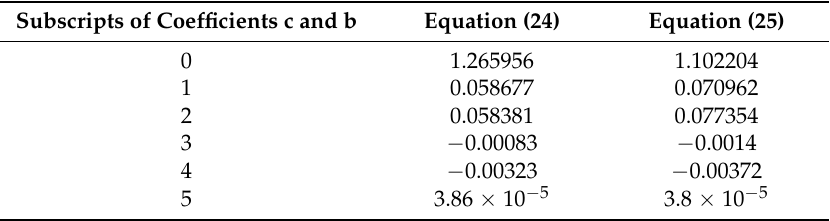
Table 4. Regression coefficients for Equations (24) and